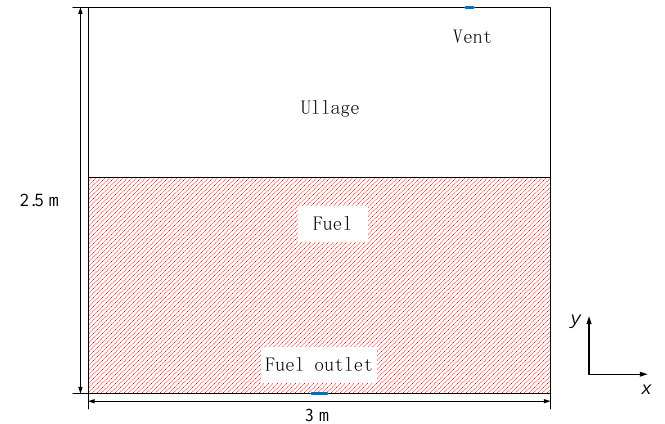
Figure 2. Fuel tank model.